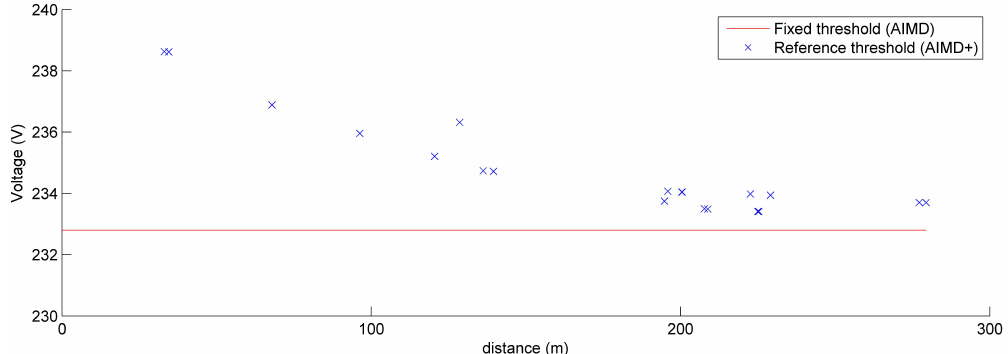
Figure 5. A plot showing the difference between the fixed voltage threshold (AIMD) and the reference voltage profile